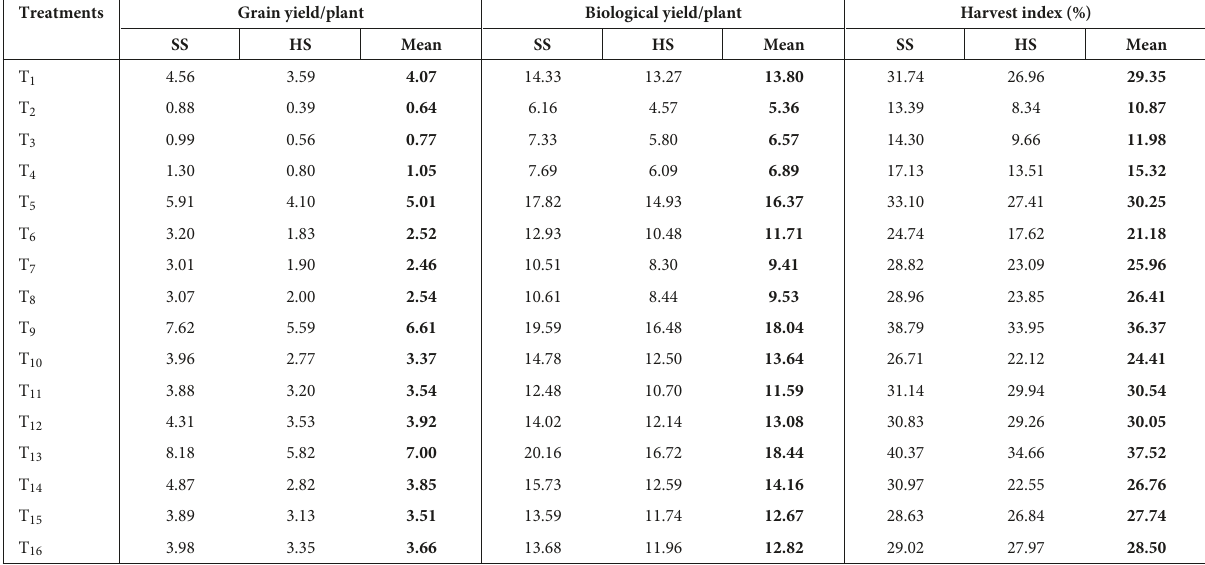
TABLE 4 Impingement of different levels of zinc (Zn) and green manure (GM) on harvest index, grain and biological yield in susceptible (SS: MNUYT-107) and highly susceptible (MNUYT-105) genotypes of mungbean.